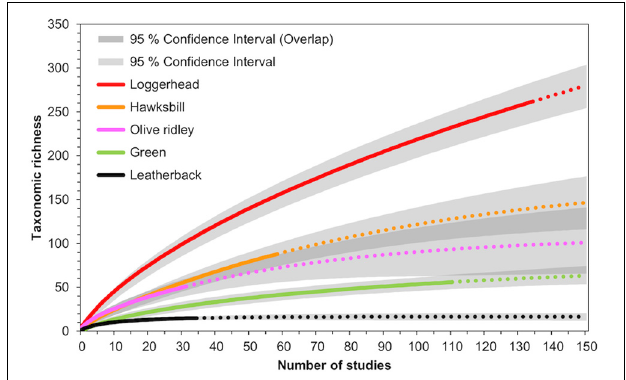
FIGURE 3 | Rarefaction curves to estimate taxonomic richness of epibionts for loggerhead, hawkbill, olive ridley, green, and leatherback sea turtles. Solid lines indicate data curves calculated from previous studies, while dashed lines represent extrapolated data.